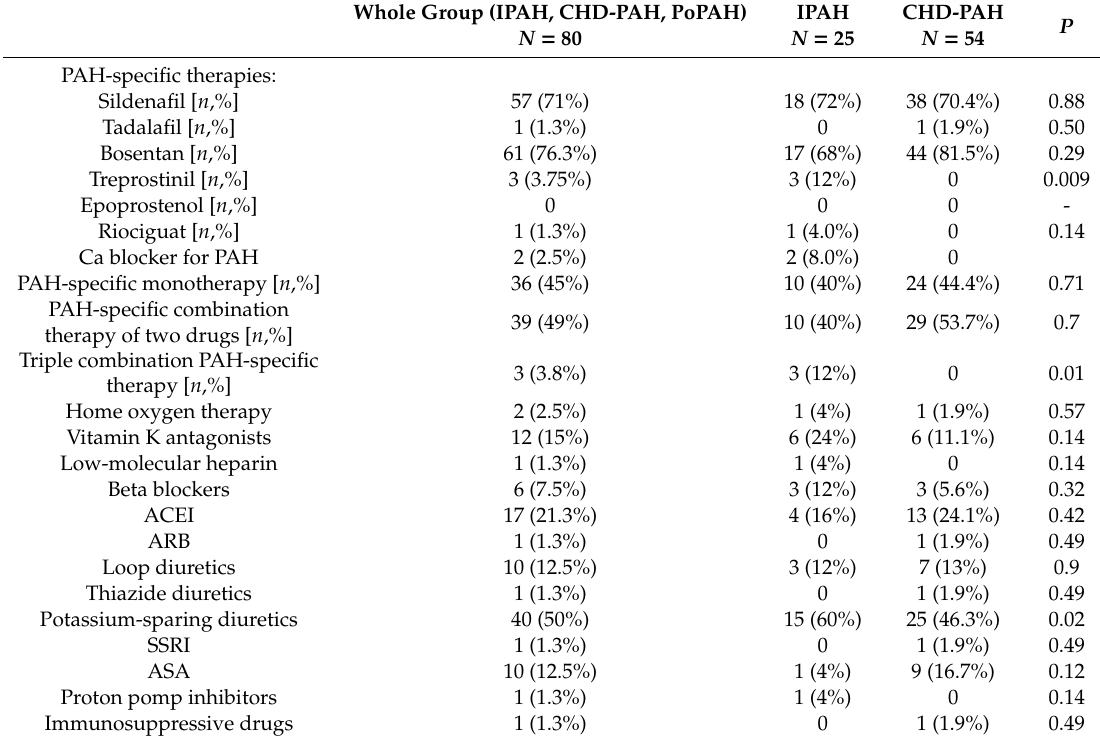
Table 4. Pharmacotherapy of pediatric patients with Pulmonary Arterial Hypertension in the BNP-PL Registry at